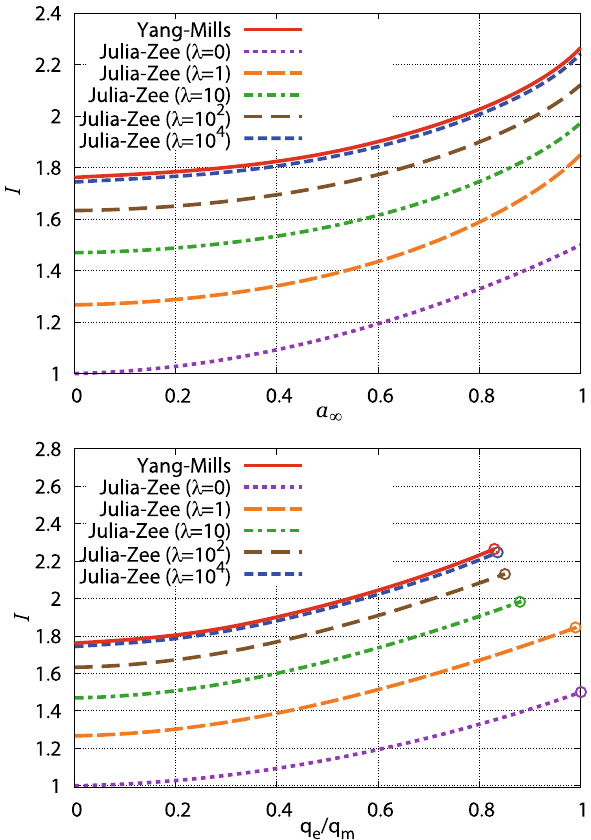
Fig. 7 The a ∞ dependence of the energy integral I for various values of λ (top panel). The plot of the energy integral I versus the ratio of the charges q e / q m (bottom panel). The circles stand for the end points of the existence of the dyon, namely a ∞ =